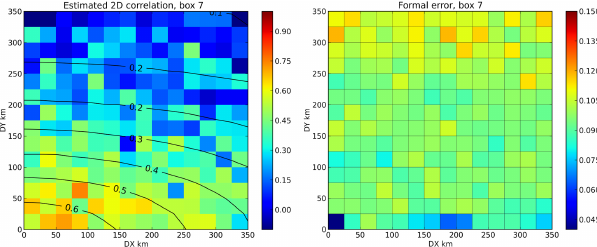
Figure 4. 2-D covariance calculated in a 20 ◦ × 60 ◦ area (box num- ber 3) in the North Pacific Ocean (left) and associated formal error (right) for temperature at 200m. Black isolines (left) correspond to the adjusted covariance model.